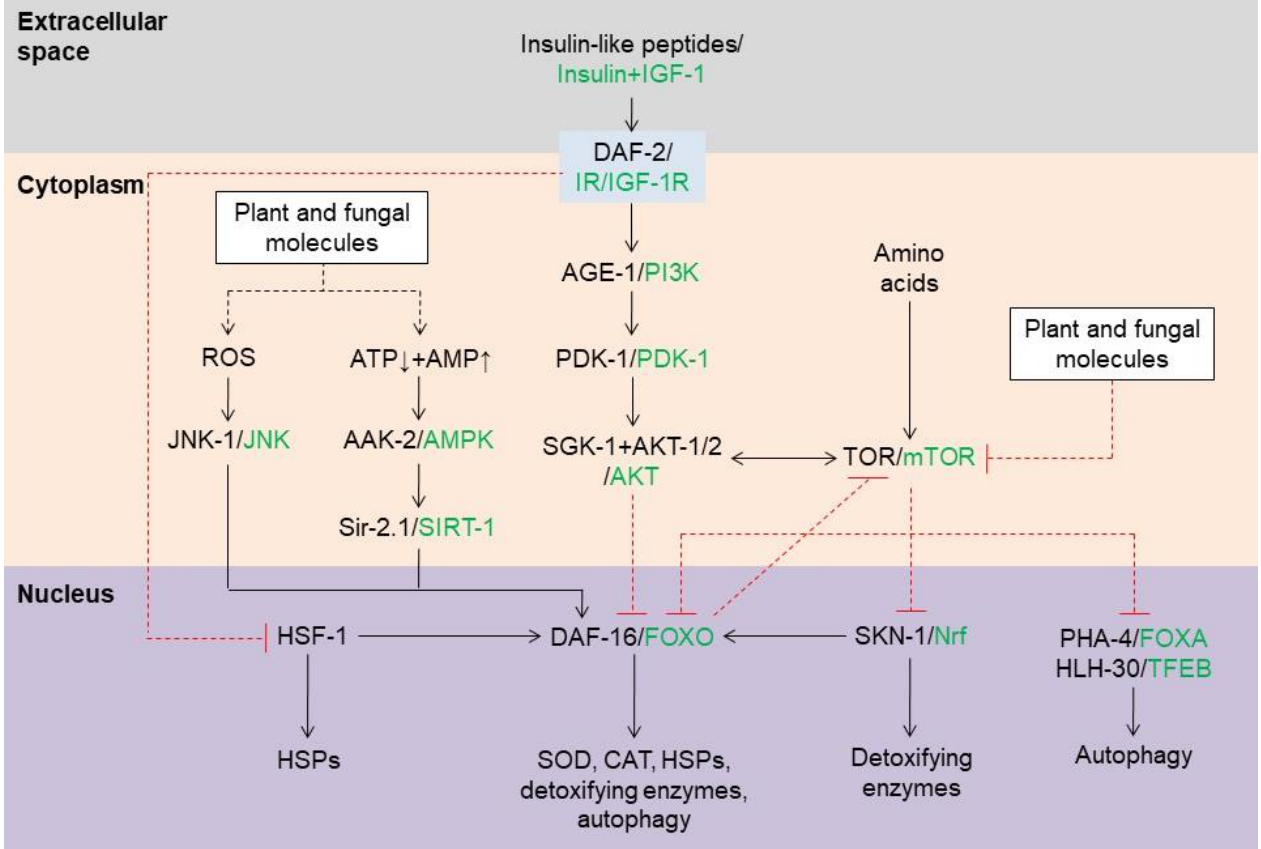
FIGURE 2: Aging-related pathways modulated by plant and fungal molecules in C. elegans . Plant and fungal molecules extend nematode lifespan by inducing the formation of ROS, by activating AAK-2/AMPK, or by inhibiting the insulin or TOR pathway. General cellular pathways are shown here, but variations may occur between cells of different tissues. Human protein homologs are given in green. Abbreviations: AGE-1, phosphatidylinositol 3-kinase age 1; AMP, adenosine monophosphate; ATP, adenosine triphosphate; AAK-2, 5’ adenosine-monophosphate- activated protein kinase catalytic subunit alpha 2; AMPK, 5’ adenosine-monophosphate-activated protein kinase; CAT, catalase; DAF, abnormal dauer formation protein; FOX, forkhead box; HLH-30, basic helix-loop-helix protein 30; HSF-1, heat-shock factor 1; HSPs, heat-shock proteins; IGF-1, insulin-like growth factor 1; IGF-1R, insulin-like growth factor 1 receptor; IR, insulin receptor; JNK, c-Jun N-terminal kinase; mTOR, mam- malian target of rapamycin; Nrf, nuclear factor erythroid 2-related factor; PDK-1, 3’ phosphoinositide-dependent protein kinase 1; PHA-4, defec- tive pharyngeal development protein 4; PI3K, phosphoinositide 3-kinase; ROS, reactive oxygen species; SGK-1, serum and glucocorticoid- regulated kinase-1; Sir-2.1, sirtuin 2.1; SIRT-1, sirtuin 1; SKN-1, skinhead 1; SOD, superoxide dismutase; TFEB, HLH transcription factor EB; TOR, target of OPEN ACCESS | www.microbialcell.com 261